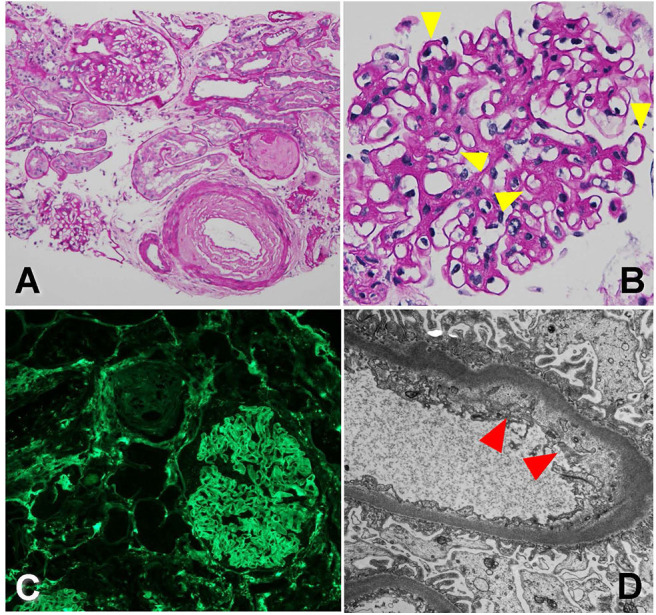
Biopsy findings showing arteriopathy and chronic thrombotic microangiopathy in patient 3. (A) There is severe arterial sclerosis, associated with focal global glomerulosclerosis, periodic acid-Schiff (PAS) stain, 200×. (B) Non-sclerosed glomeruli reveal irregular thickening and segmental remodeling of the capillary loops, with occasional double contours (yellow arrowheads), PAS stain, 400×. (C) There is dull reactivity for fibrin along the glomerular capillary walls on immunofluorescence microscopy, fluorescein isothiocyanate (FITC) stain, 200×. (D) On electron microscopy, glomerular capillary walls reveal subendothelial widening by electron lucent material (red arrowhead), 10,000×.